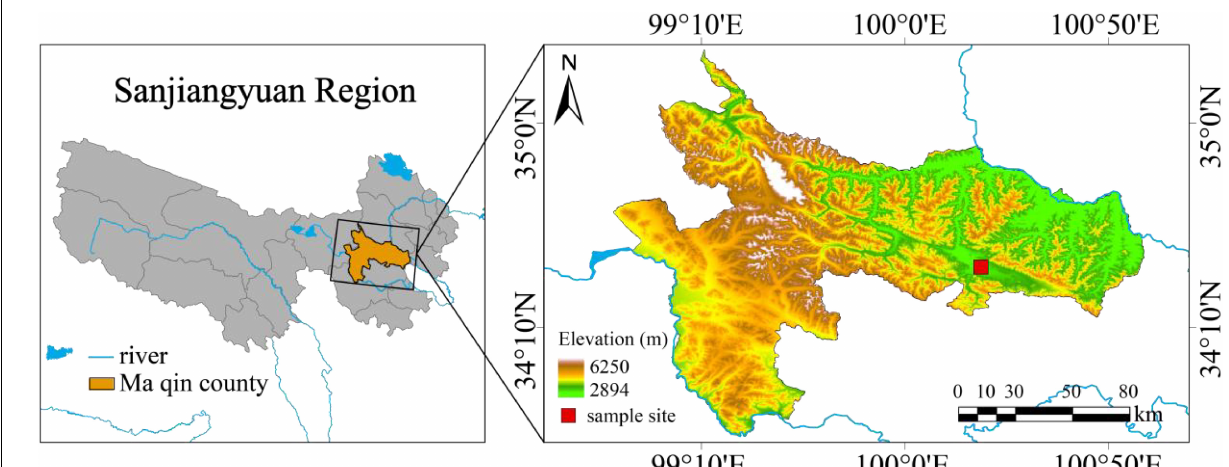
FIGURE 1 | Location of the study site.